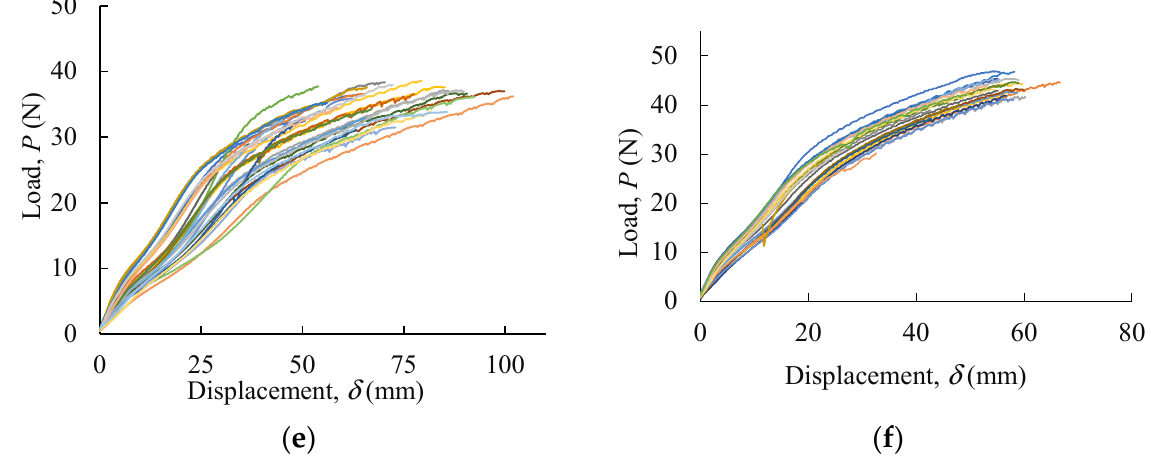
Figure 8. Load–displacement curves of PVA structures: ( a ) 1Y; ( b ) 6PY; ( c ) 6Y; ( d ) 6BY; ( e ) 8BY; ( f ) 10BY.